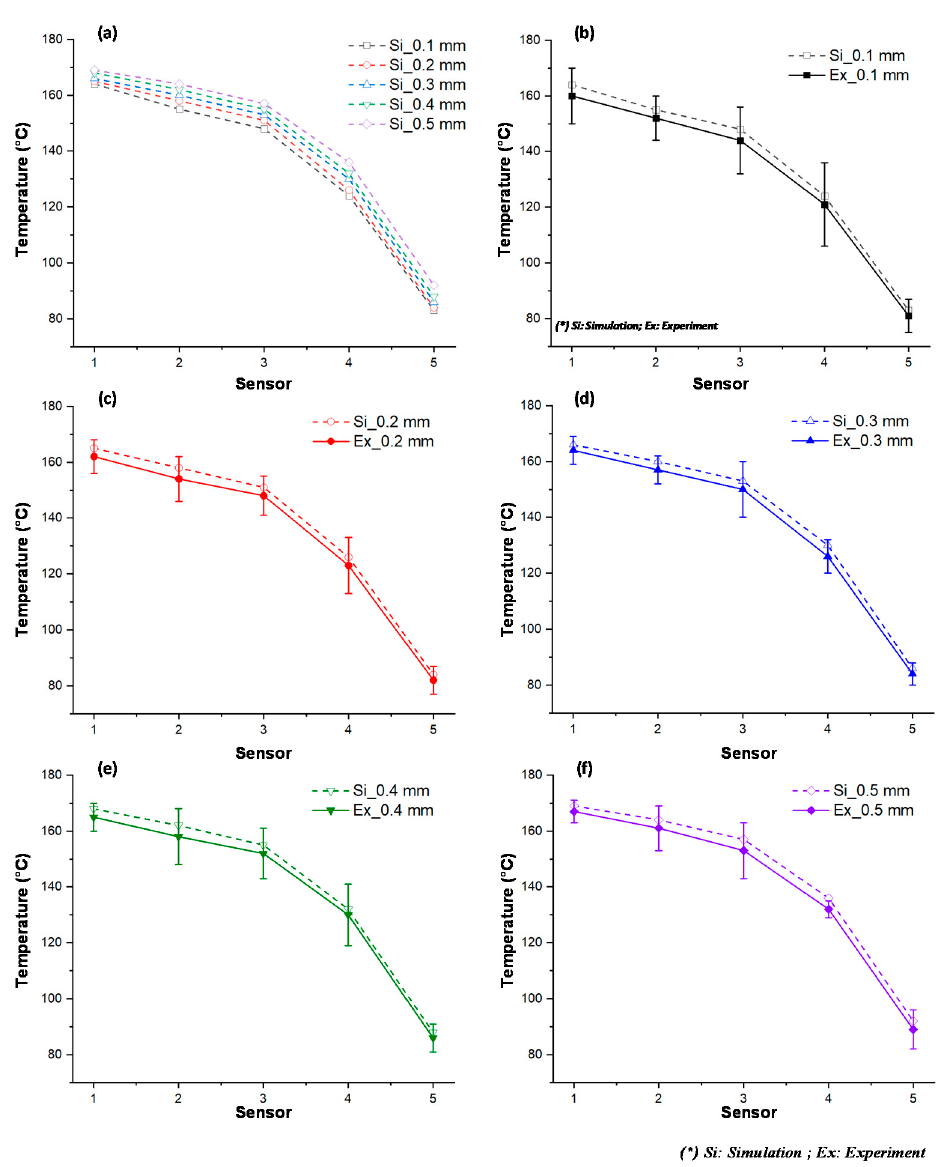
Figure 10. Temperature along the center line in simulations with different product thicknesses.